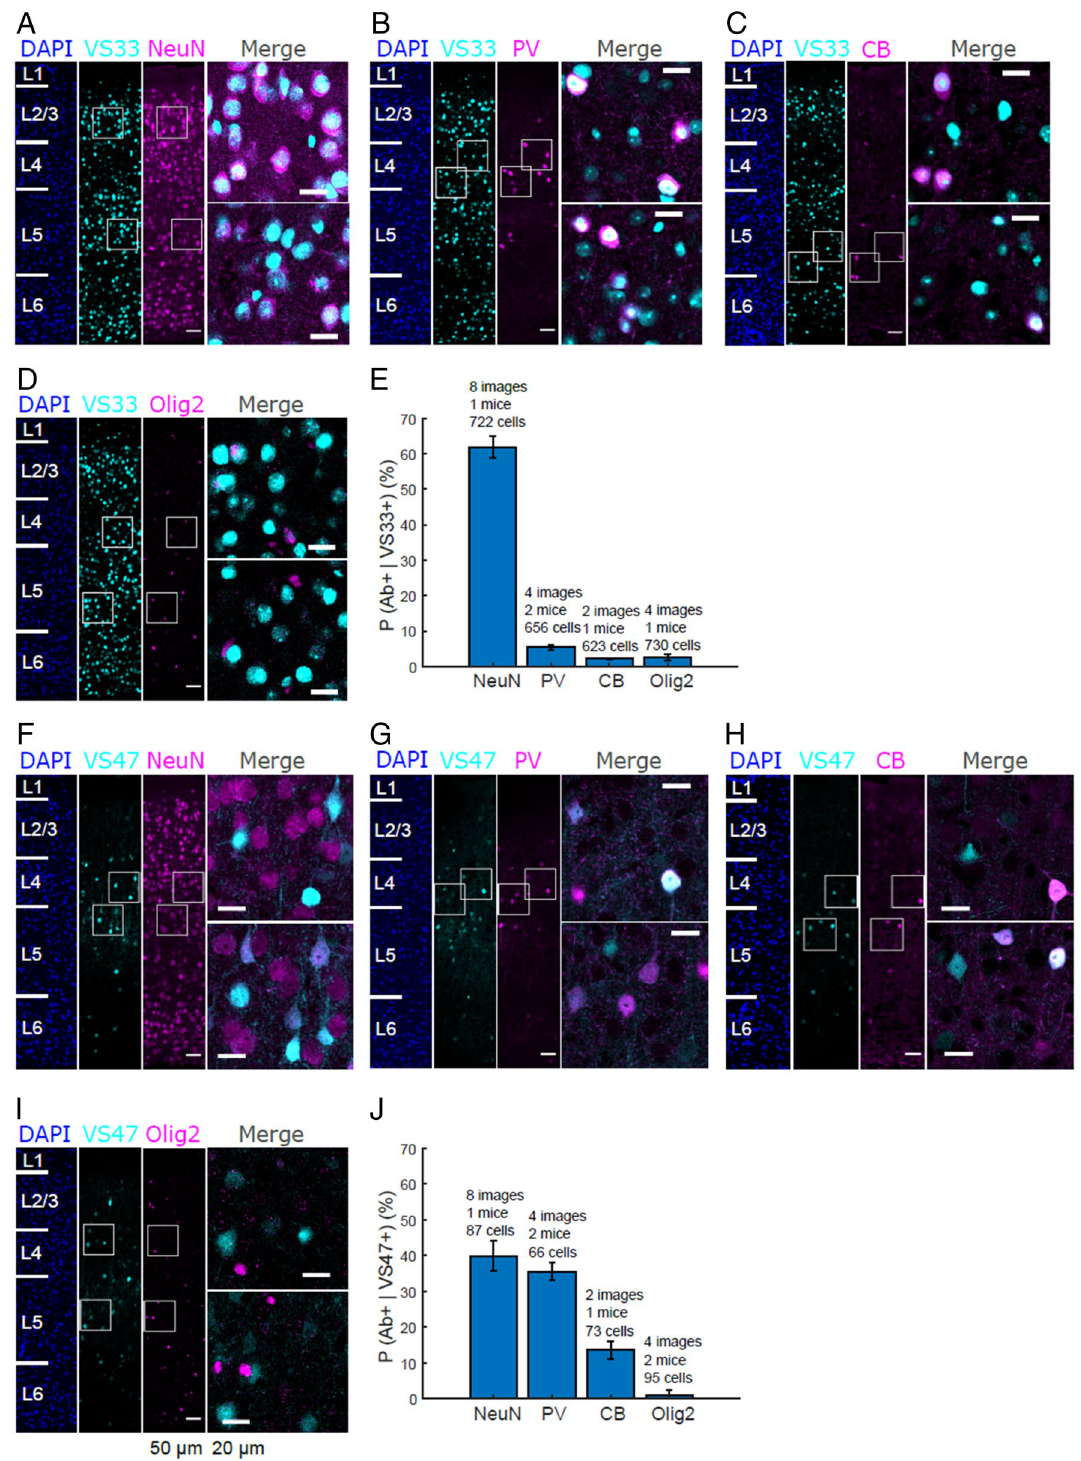
Figure 6. Cell type characterization of validation sequences VS33 and VS47 using immunostaining in coronal sections of the auditory cortex. ( A – D ) Fluorescence microscopy images of VS33-driven mTFP expression (cyan) and immunostaining of cell type marker antibodies (magenta) in the same fields of view. Cell type marker proteins are NeuN (A), Parvalbumin (PV) ( B ), Calbindin (CB) ( C ) and Olig2 ( D ). Six neocortical layers indicated on DAPI image. ( E ) Quantification of the percentage of VS33-positive cells that are co-stained by the cell type markers in (A-D) (mean across images ± SD). VS33 drives expression in mainly neuronal cells. ( F – J ) Analogous to (A-E), but for VS47-driven mTFP expression. VS47 drives expression prominently in the